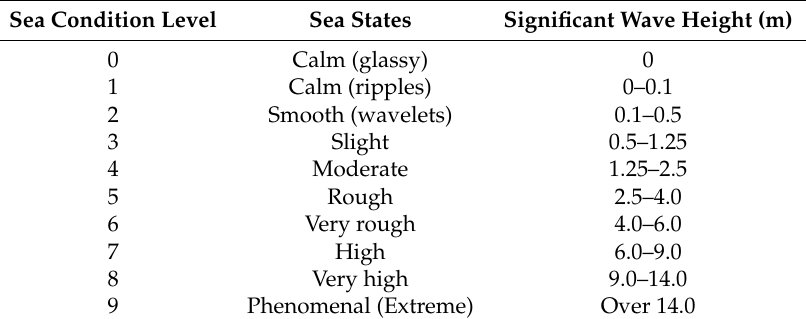
Table 2. Definition of sea level conditions